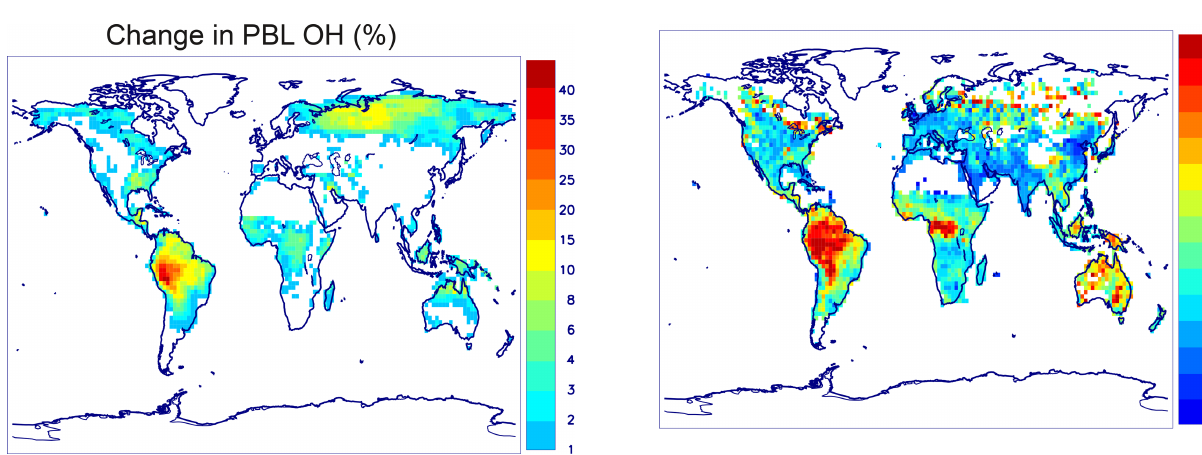
Figure 8. Percentage ratio of annual NO x net loss due to or- ganic nitrate formation (i.e. their combined aerosol sink and de- position sink) to the total annual NO x emission. Blank areas are those with annually averaged NO x emissions lower than 5 × 10 9 molec.cm − 2 s − 1